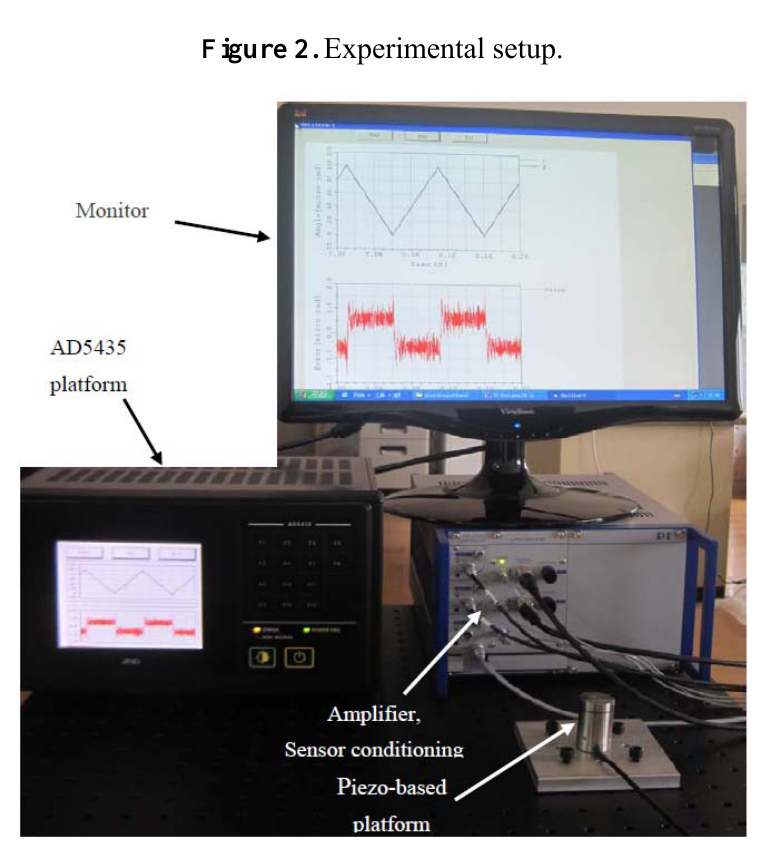
Figure 2. Experimental